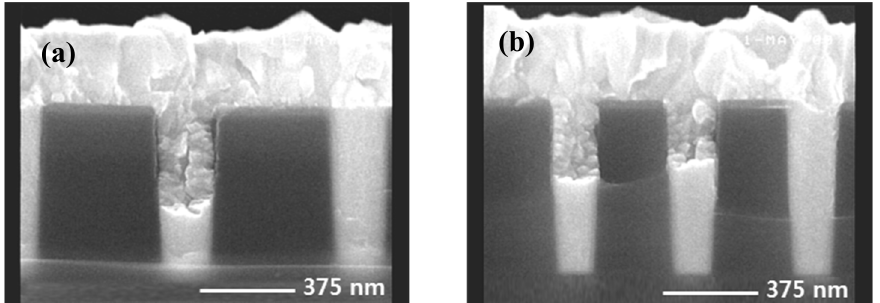
Figure 2. SEM image of cross section after tungsten deposition of contact hole size ( a ) 0.16 µ m with interlayer dielectric (ILD) thickness 6700 Å and ( b ) 0.14 µ m with ILD thickness 6700 Å.